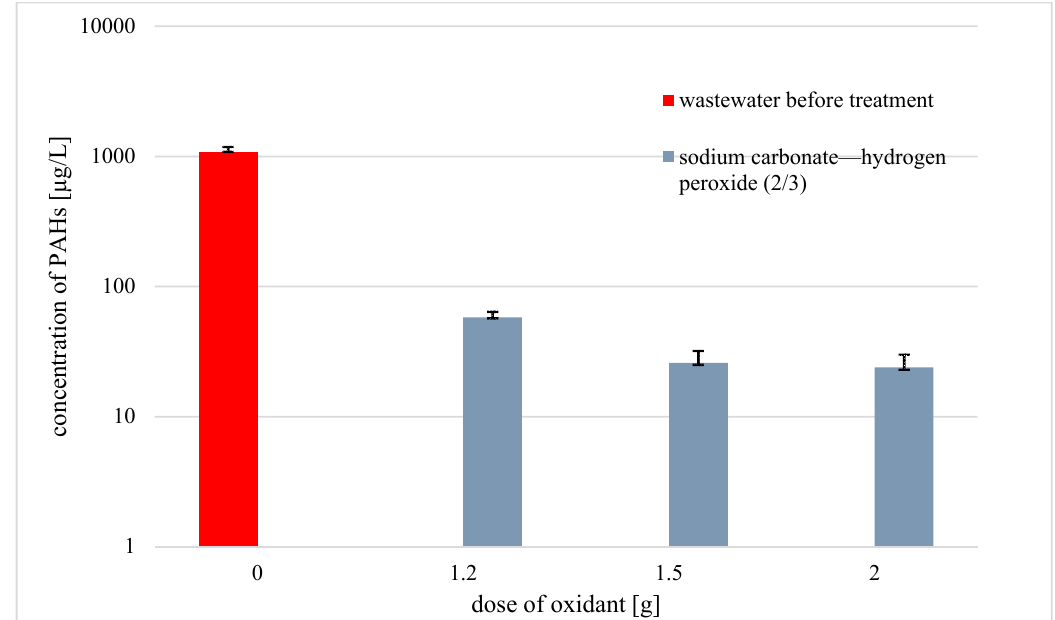
Figure 1. The changes in the concentration for the sum analyzed PAHs depending on dose level of oxidant. The standard deviation for each result is marked on the